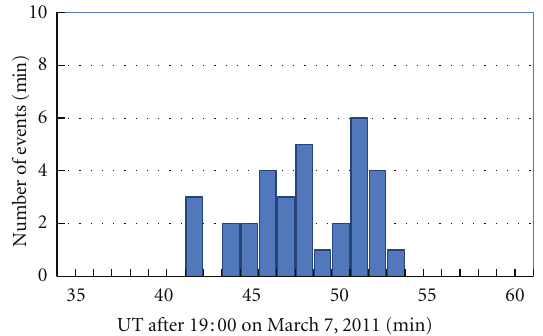
Figure 12: The departure time distribution of solar neutrons. The histogram has been made being based on neutrons detected within a cone angle of 20 degrees from the solar direction. From the energy, the time of flight was calculated and converted the value into the departure time of neutrons from the Sun. There were two bumps around 19: 48UT and 19:52 UT.